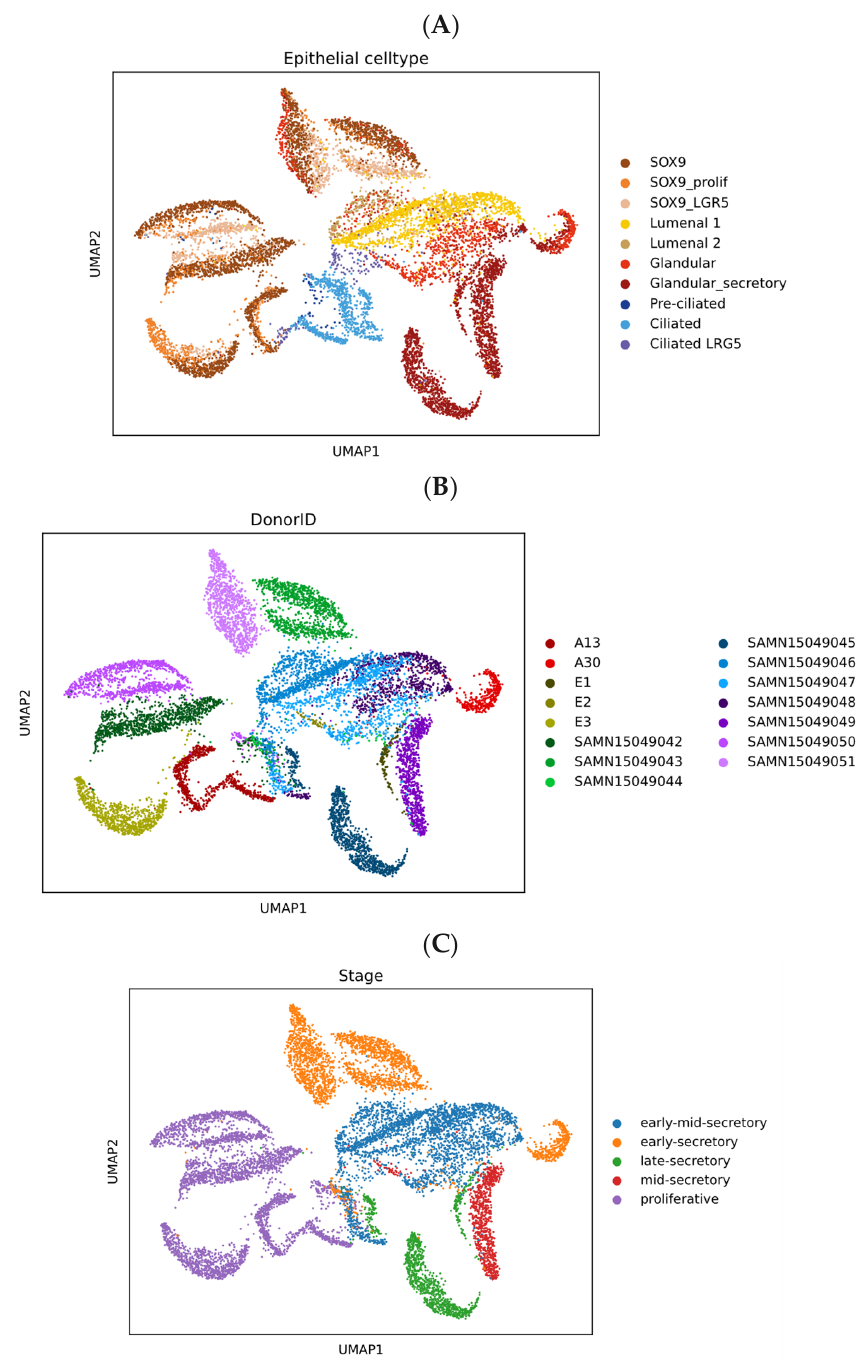
Figure 5. Uniform Manifold Approximation and Projection (UMAP) clustering of the scRNA-seq dataset (n = 10,729 cells with unadjusted sampling, so showing different cell numbers per donor) representing endometrial epithelial subsets ( A ), donor individuals ( B ) and cycle stages ( C ) reported by Garcia-Alonso et al. [21]. The epithelial subsets bearing SOX9 and LGR5 are specific phenotypes of interest to these authors, with SOX9 being enriched in, but not exclusive to, the proliferative phase. LGR5 cells are mainly luminal and sometimes